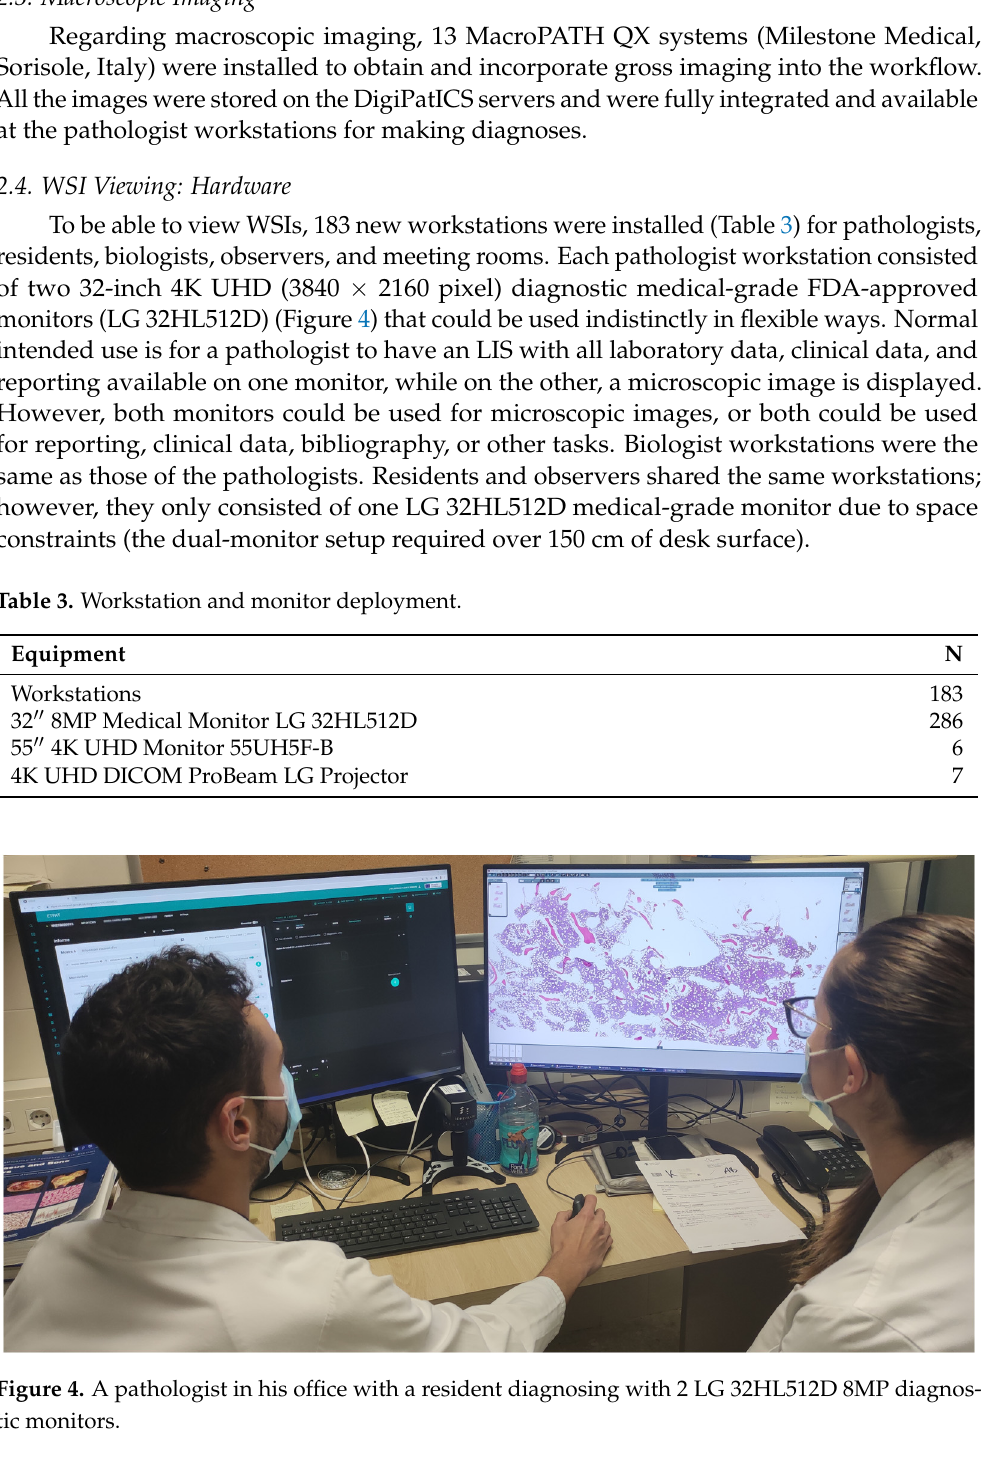
Figure 5. Residents diagnosing using a 55-inch 4K UHD monitor (55UH5F-B). Table 3. Workstation and monitor deployment. Equipment